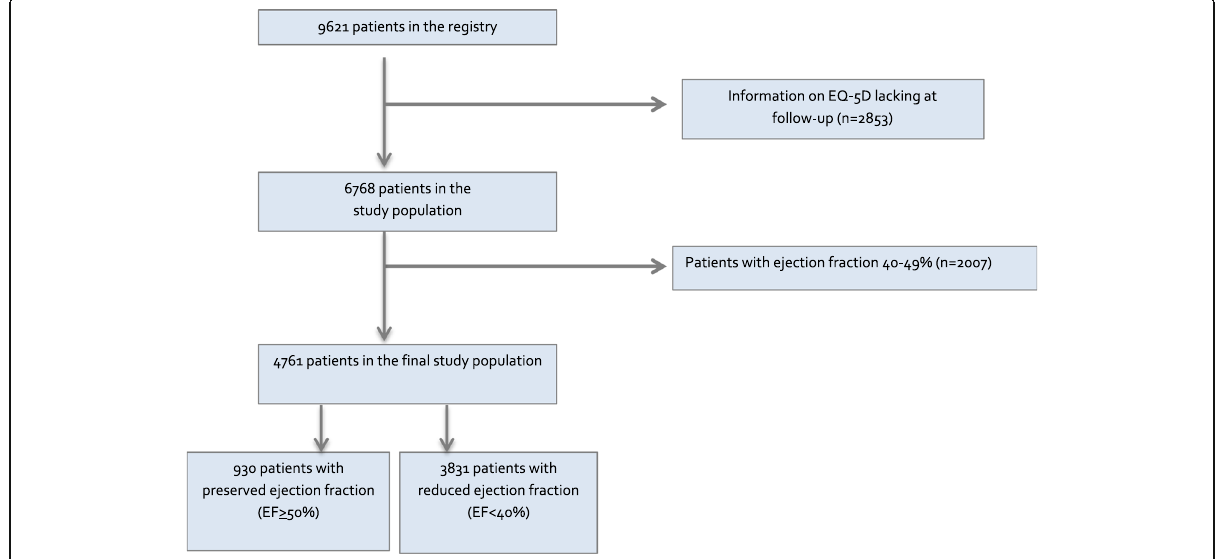
Fig. 1 Flow chart over the selection process of the patients from the Swedish HF Registry